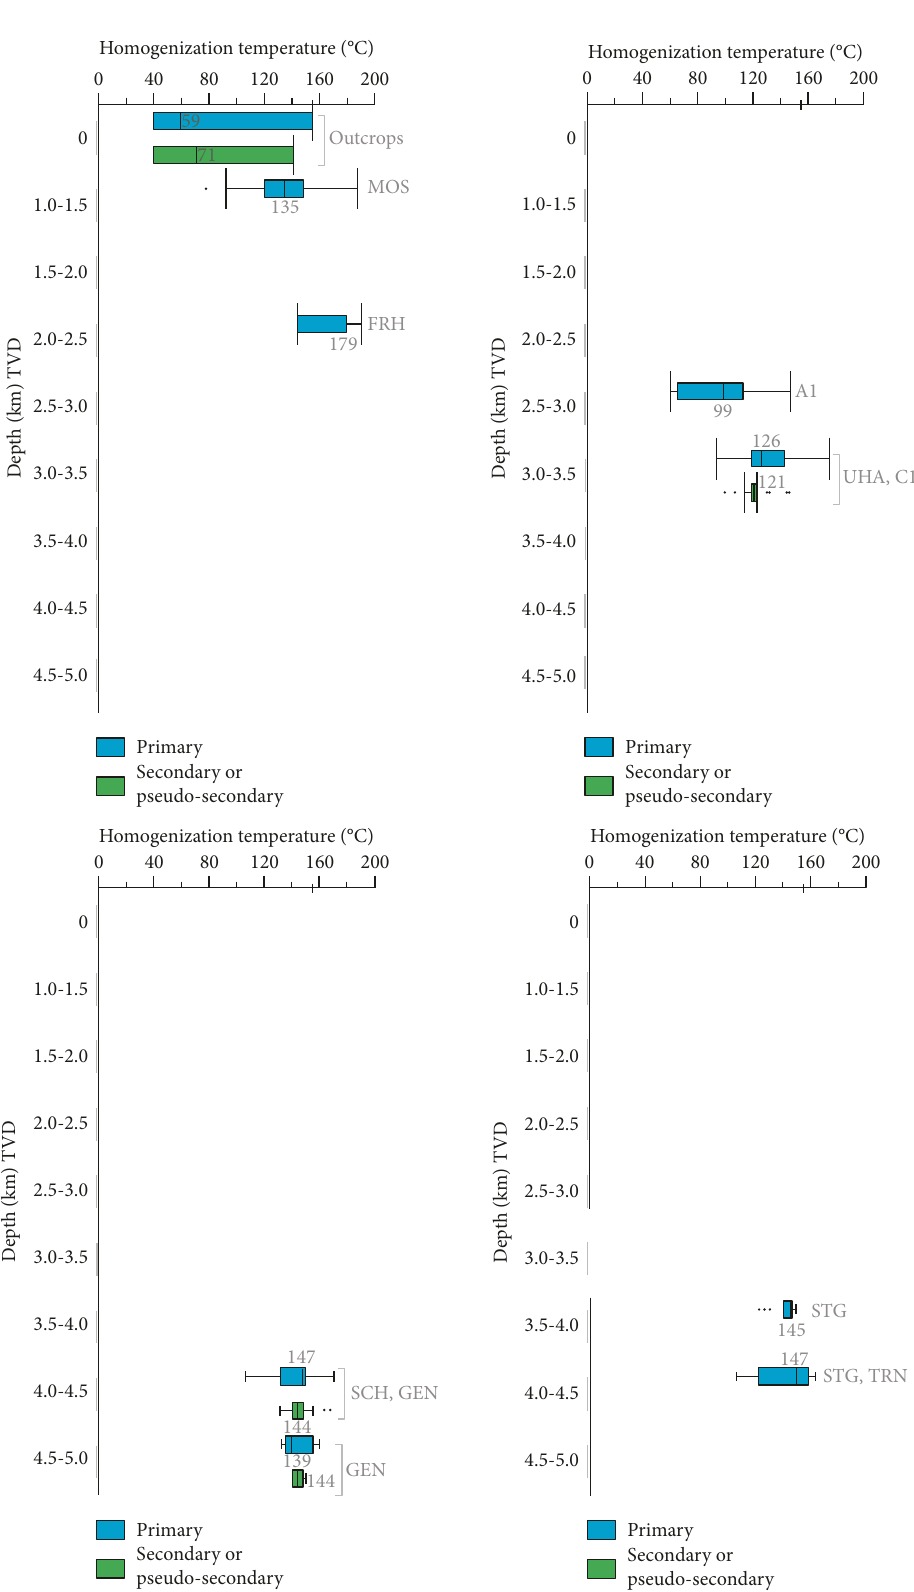
Figure 8: Boxplots of homogenization temperature versus true vertical depth of the calcite and dolomite 2-phase fl uid inclusions from the wells in the Molasse Basin. In gray, the sampled wells are named using the same abbreviation as Figure